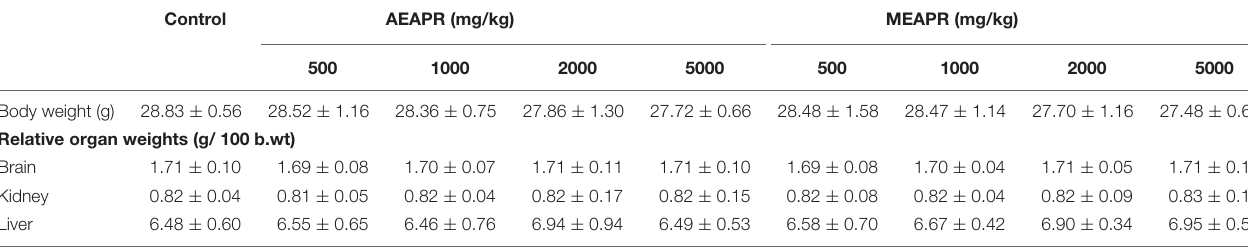
TABLE 1 | Effect of a single oral administration of AEAPR and MEAPR on body weight and relative organ weights of mice. Control